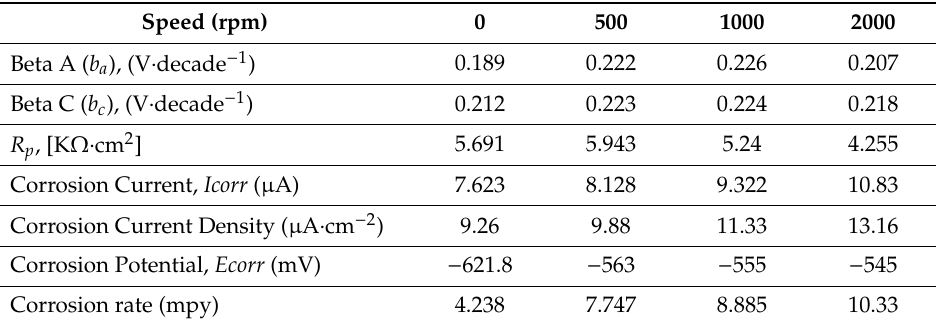
Table 9. The e ff ect of rotation speed on corrosion rate at 293 K. Table 9. The effect of rotation speed on corrosion rate at 293 K.